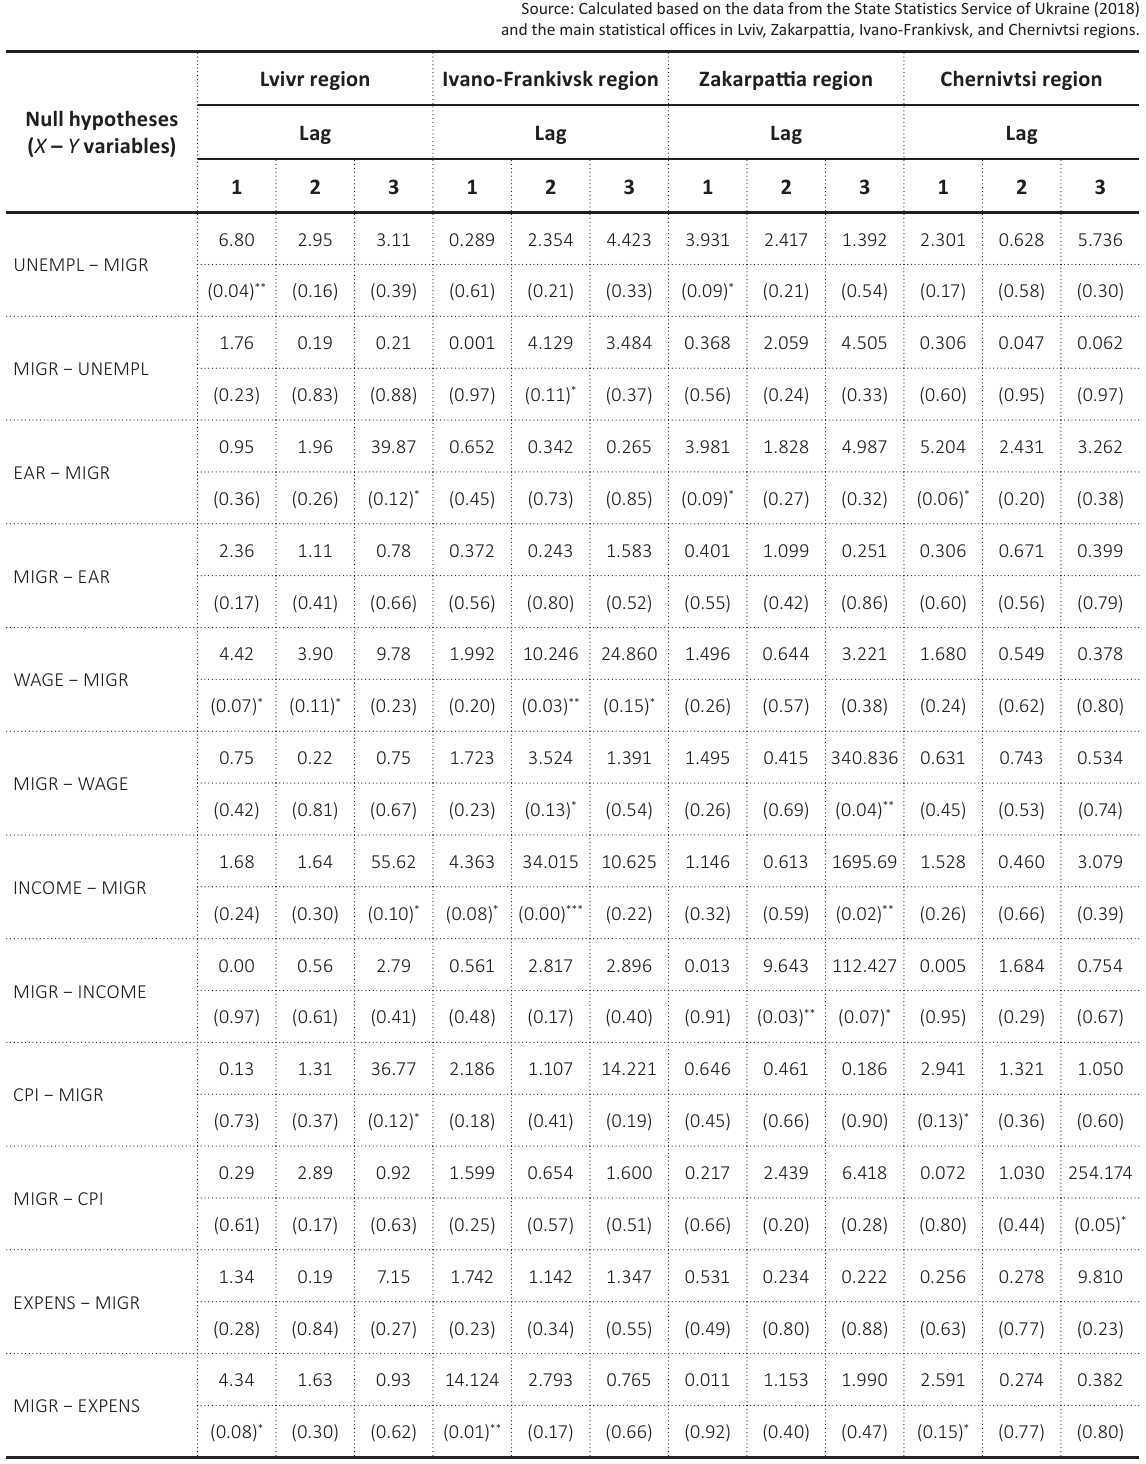
Table A1. Granger causality interaction between population migration and social development of the Carpathian Region,